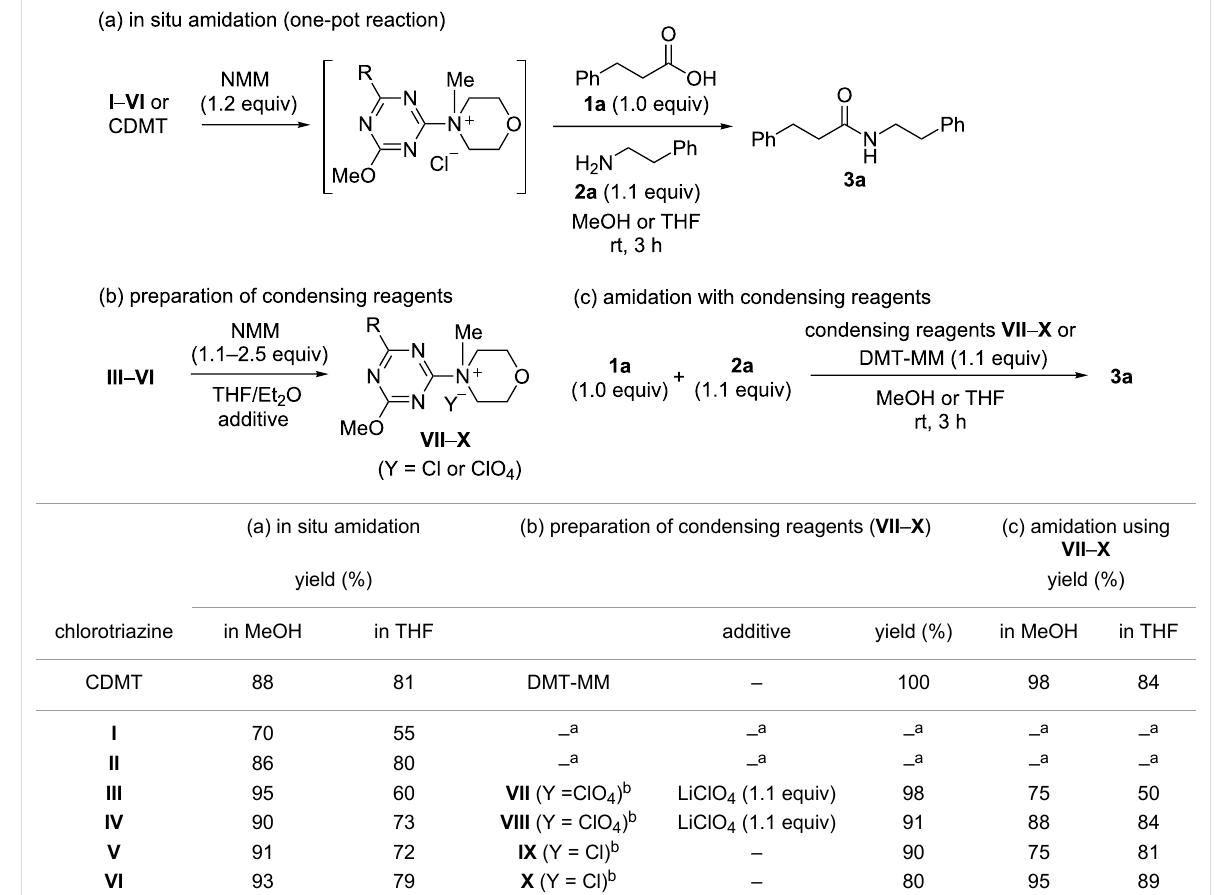
Table 1: Amide-forming reactions using chlorotriazines ( I – VI ) or triazinylammonium salts ( VII – X ).